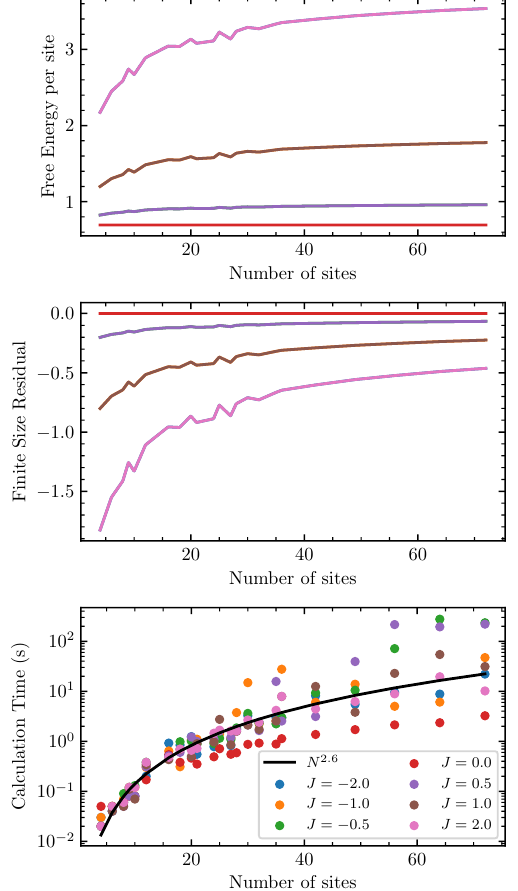
Figure 28: The free energy per site from PyTNR (top) and computation time (bottom) for the 2D Ising model on a square lattice with open boundary conditions for h = 0 and several J is shown as a function of the number of sites N . The lattice dimensions were chosen to have aspect ratios no greater than 3 and to cover a range of N without large gaps. Note that three samples were drawn for each system